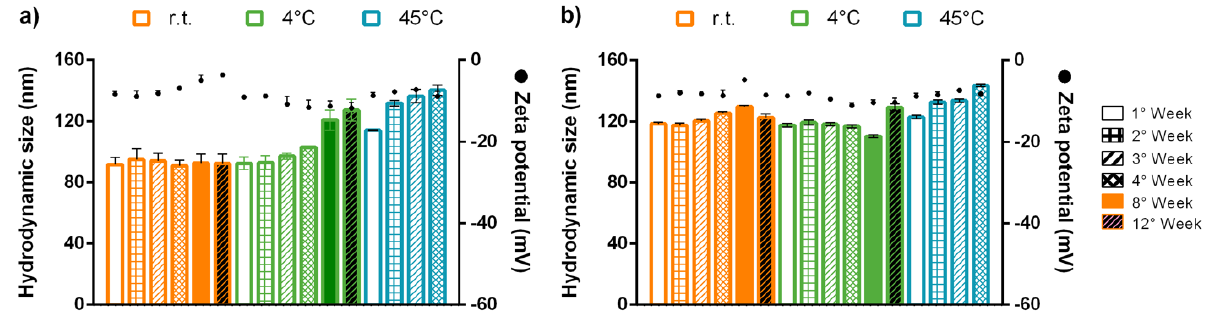
Figure 4. Colloidal stability studies of ( a ) NLC and ( b ) NLC-Rho at room temperature and 4 °C for 12 weeks and 45 °C for 4 weeks. Parameters evaluated were hydrodynamic size (nm), and zeta potential (mV). n = 3 ± SD.